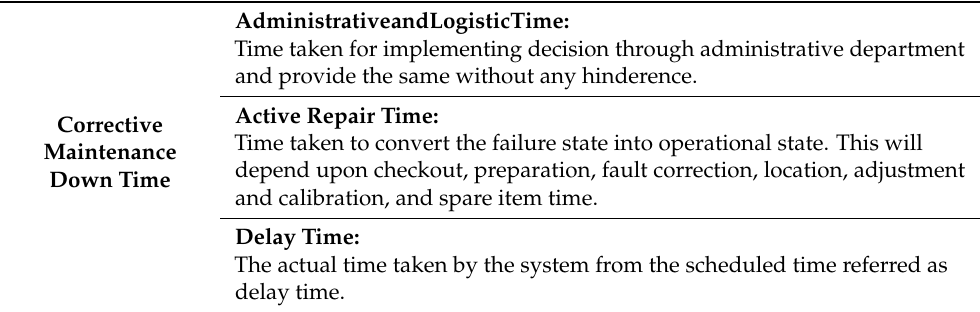
Table 2. Corrective maintenance downtime modules.